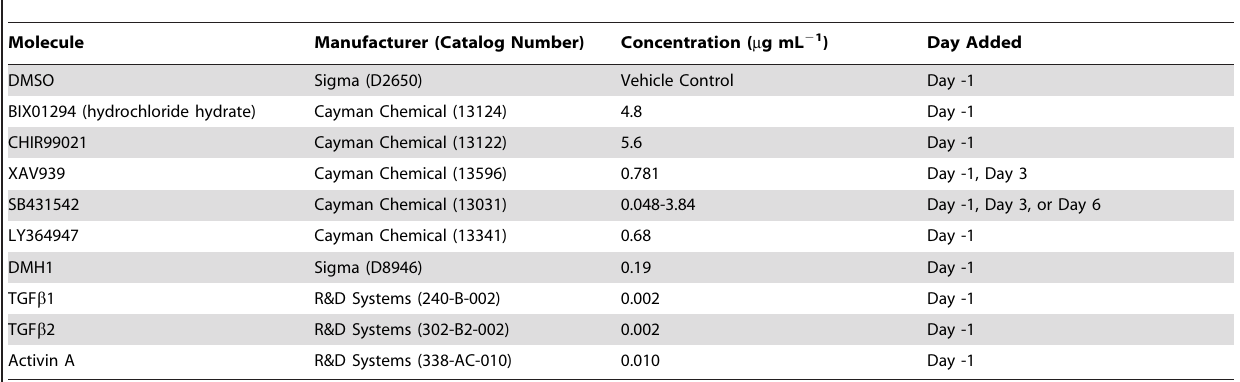
Table 1. The small molecules and growth factors that were tested for direct reprogramming of fibroblasts to iCMs.